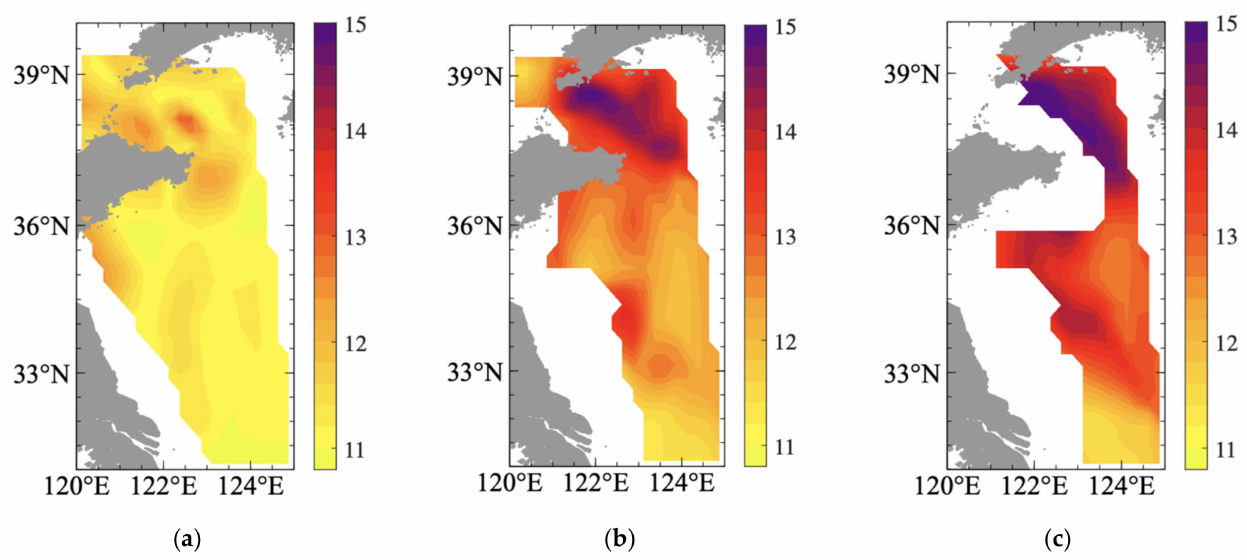
Figure 4. Observed DIN distribution in August 2019 at ( a ) 10 m, ( b ) 20 m, and ( c ) 30 m in investigated region (unit: